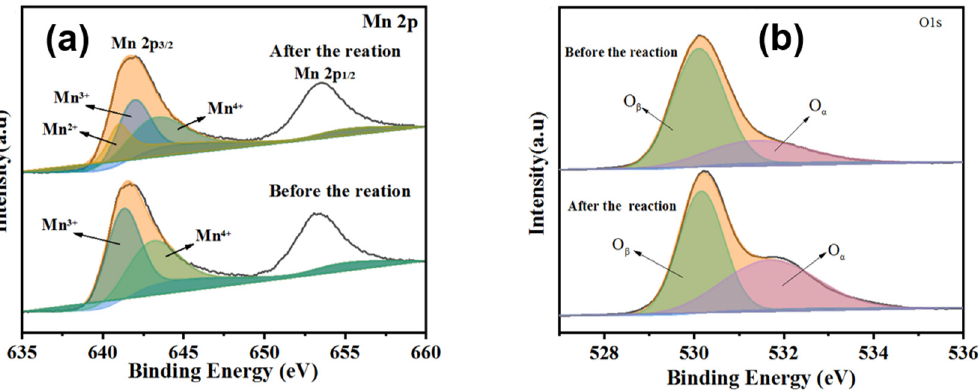
Figure 7. The XPS spectra of the MF catalyst before and after the anti-sulfur reaction: ( a ) Mn2p; ( b ) O1s.